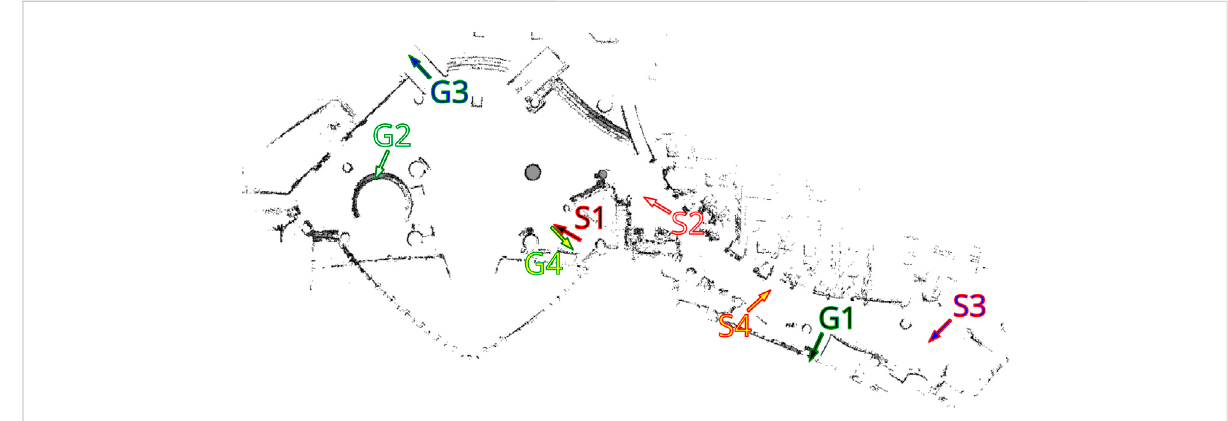
FIGURE 9 The occupancy map of the ATC shopping mall. The start and goal poses are outlined red and green,